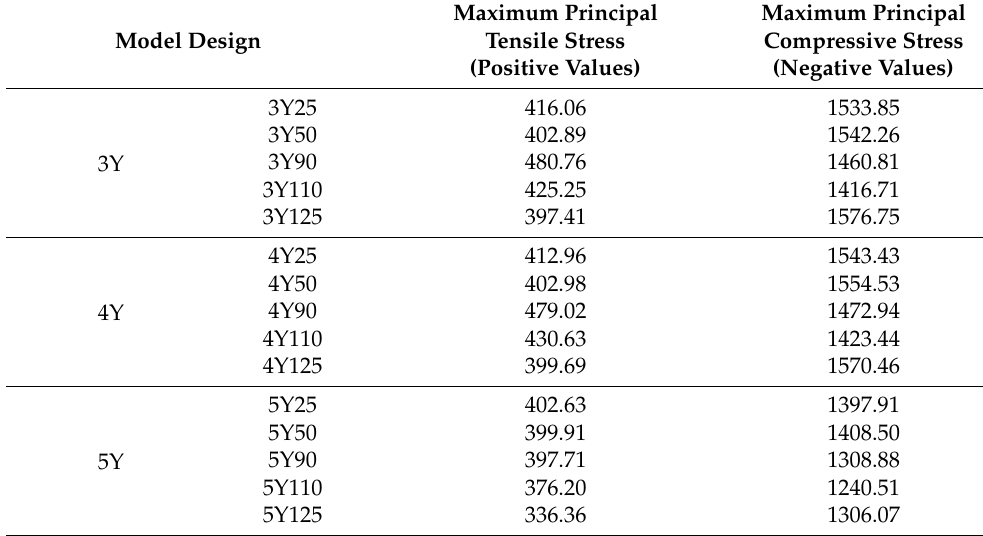
Figure 11. The hemispherical stress fields on loading within the model of ( a ): 3Y125; ( b ): 4Y125; ( c ): 5Y125; and ( d ): schematic view of the impact stress field. The compressive stress (negative) was concentrated at the impact zone and changed into tensile residual stress (positive) approaching the surface. 5Y125 produced deeper erosive cut compared to 3Y125 or 4Y125 with a depth of 2 µ m. Below the material erosion, plastic deformation zone was developed. 5Y125 exhibited deeper stress relaxation zone with a depth of 19 µ m compared to 3Y125 or 4Y125. MPS: maximum principal stress. Table 2. Maximum principal stresses in the model designs of each zirconia subgroup. All values in megapascal